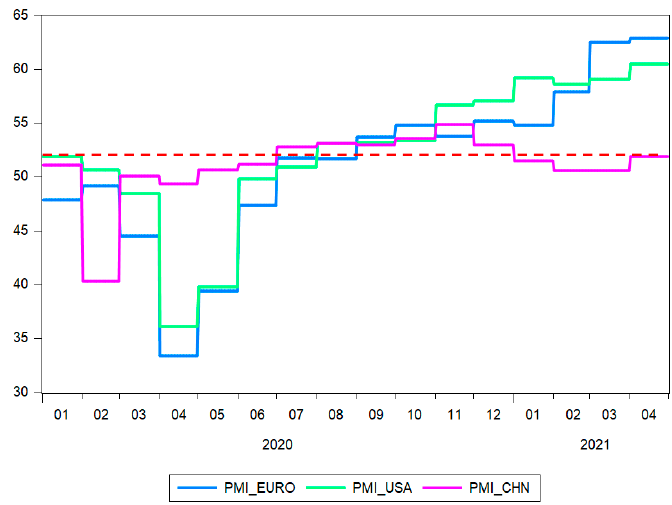
Figure 7. Purchasing Managers’ Index. Source: authors’ contribution using EViews 10 software.